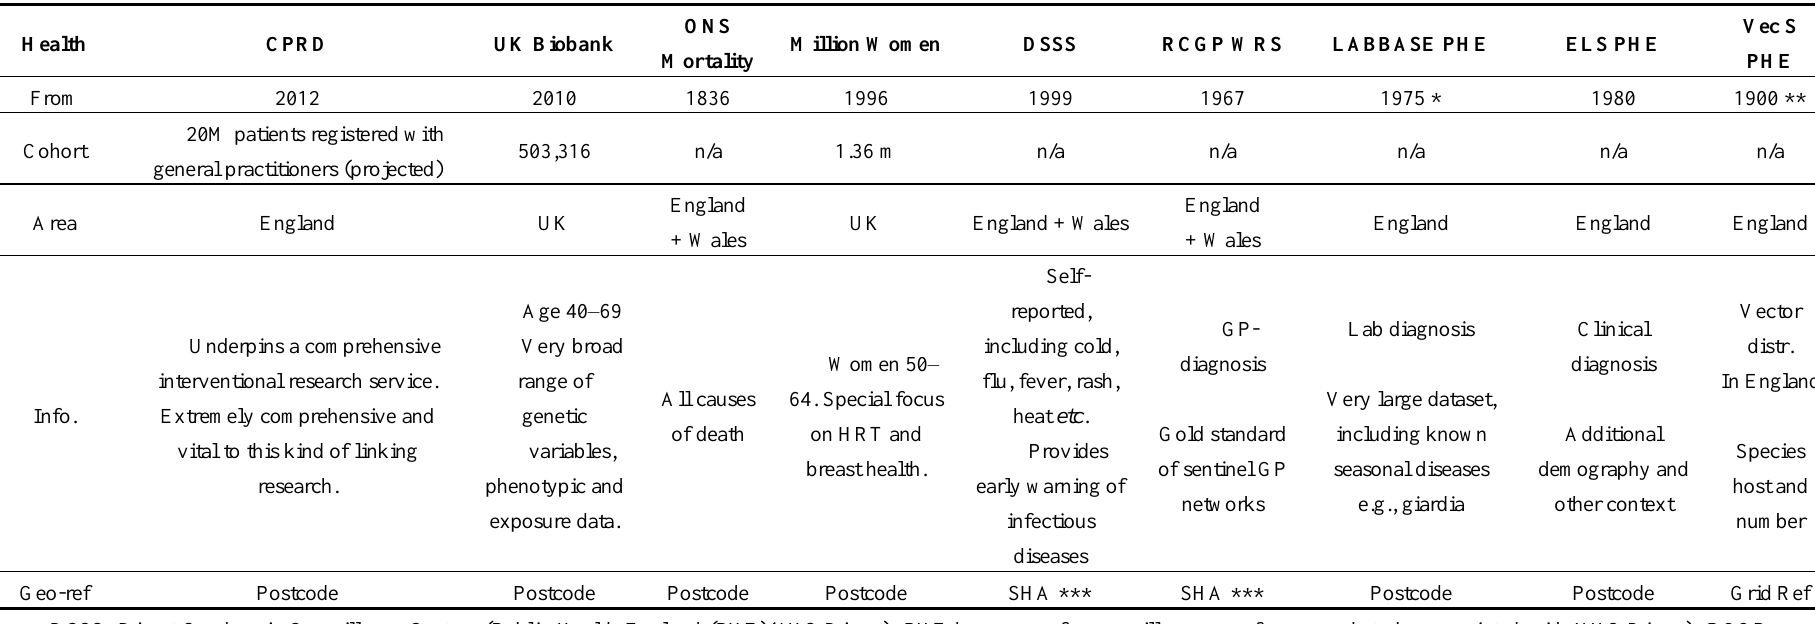
Table 3. Summary table of health databases the MED MI Partnership has identified, as well as other databases for potential future collaborations (more details at